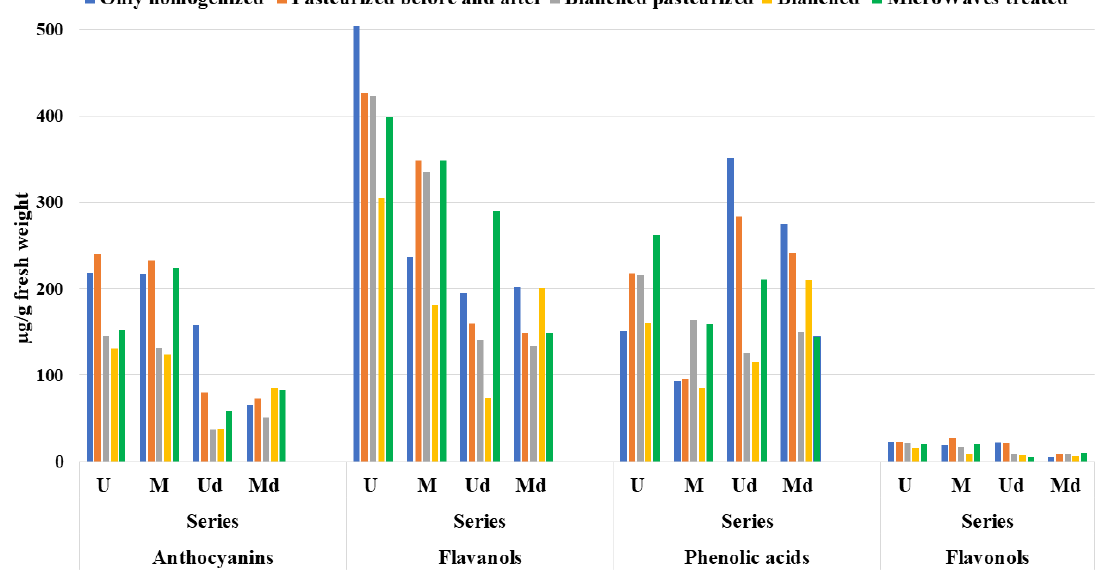
Figure 3. E ff ects of the di ff erent treatments applied to the strawberry cultivar Clery, U and M series, on Figure 3. Effects of the different treatments applied to the strawberry cultivar Clery, U and M series, the phytocomplex. on the phytocomplex.